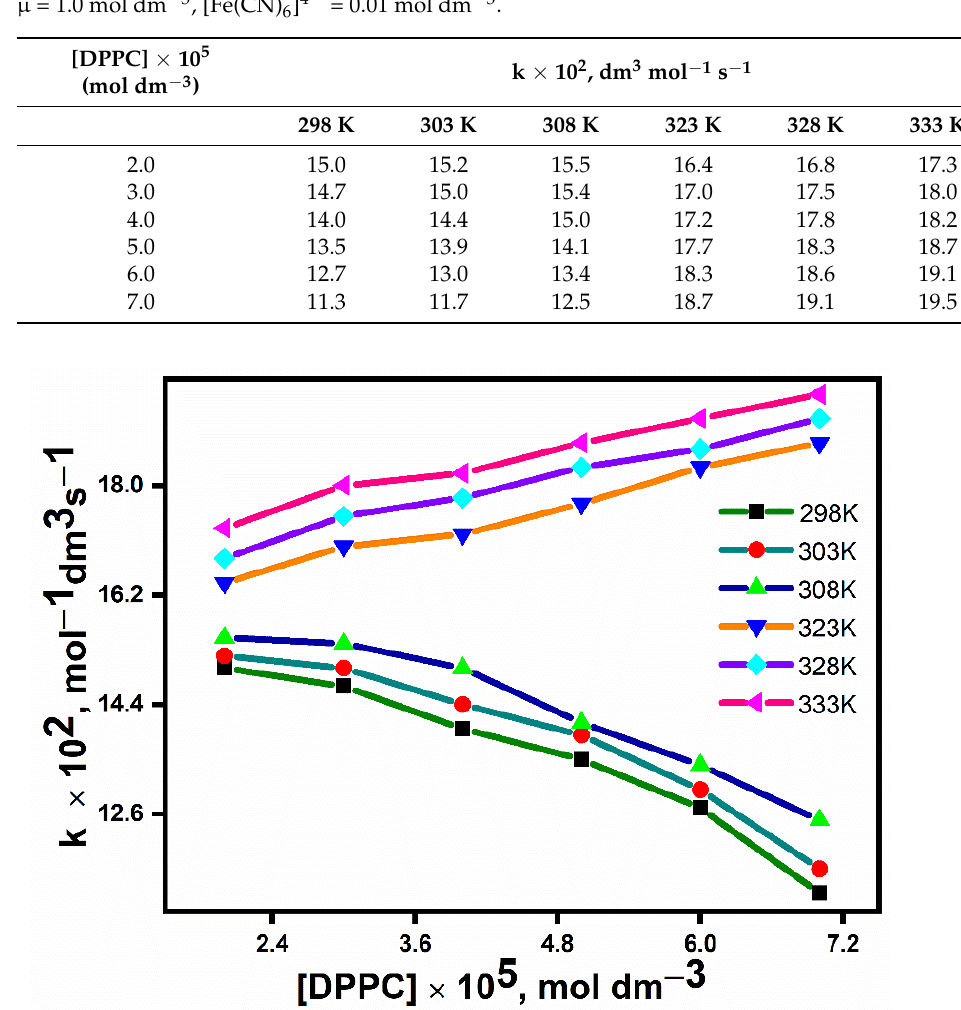
Figure 1. Plot of k against DPPC for cis-[Co(ip) 2 (C 12 H 25 NH 2 ) 2 ](ClO 4 ) 3 under various temperatures; cis-[Co(ip) 2 (C 12 H 25 NH 2 ) 2 ](ClO 4 ) 3 = 4 × 10 − 4 mol dm − 3 , μ = 1.0 mol dm − 3 , [Fe(CN) 6 ] 4− = 0.01 mol dm − 3 .